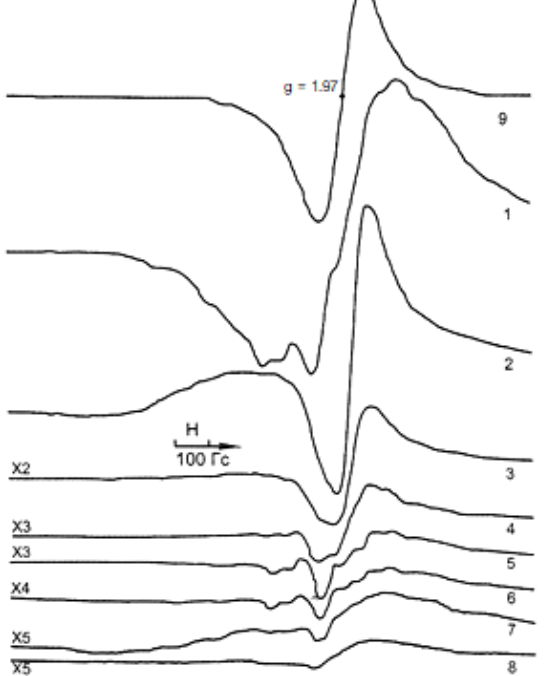
Figure 1. EPR spectra of 10% V/ γ -Al 2 O 3 . 1—initial catalyst after heating in air for 1 h at temperatures: 2—300 ◦ C; 3—400 ◦ C; 4—500 ◦ C; 5—600 ◦ C; 6—700 ◦ C; 7—800 ◦ C; 8—900 ◦ C; 9—initial VOSO 4 · 3H 2 O.